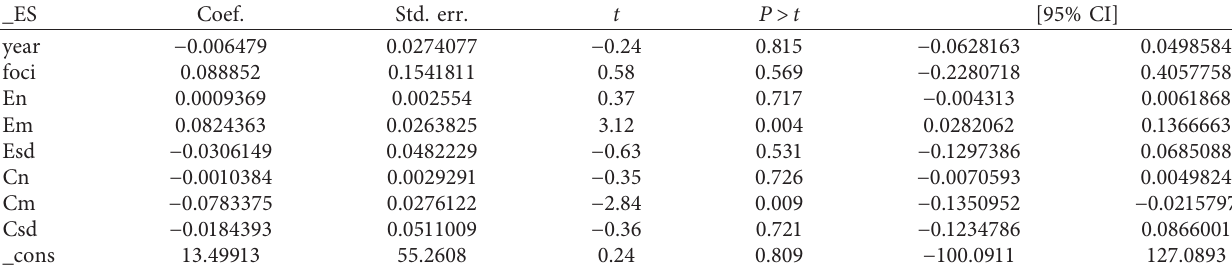
Table 4: Metaregression results presenting the potential factors contributing to heterogeneity.